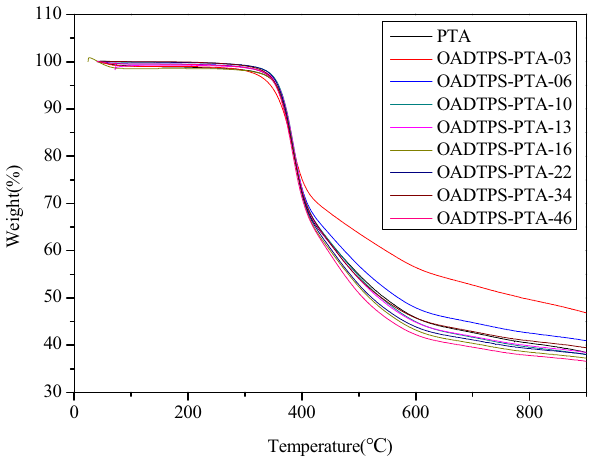
Figure 9: TGA curves of cured PTA and OADTP - PTA resins.